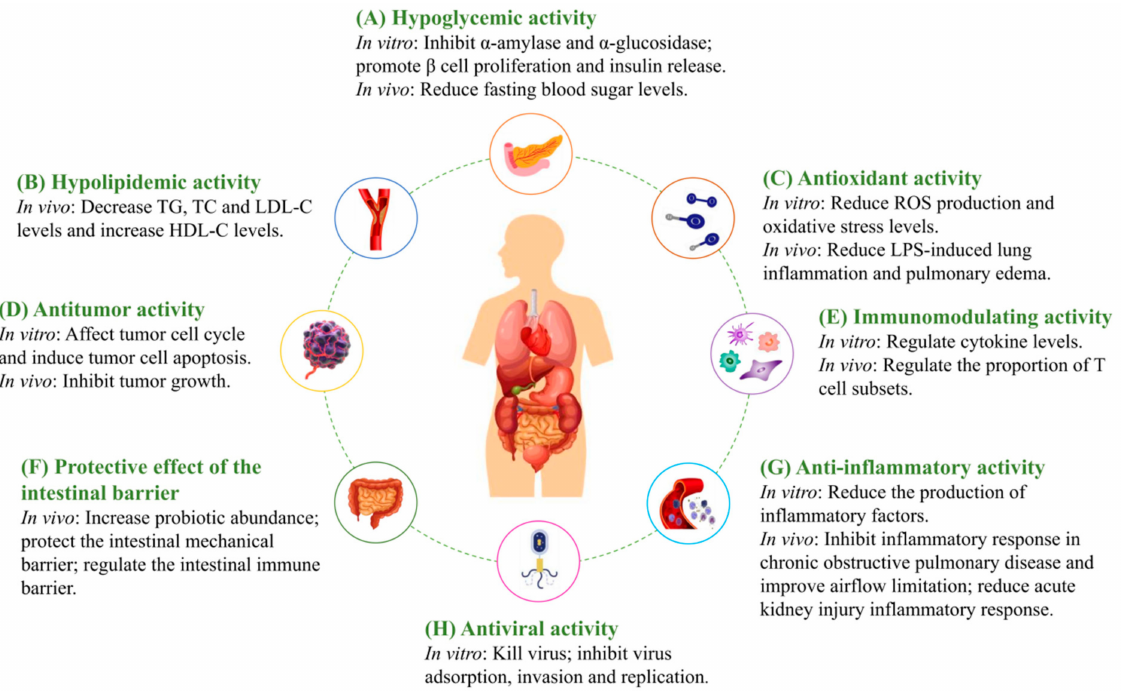
Figure 2. The biological activities and molecular mechanisms of